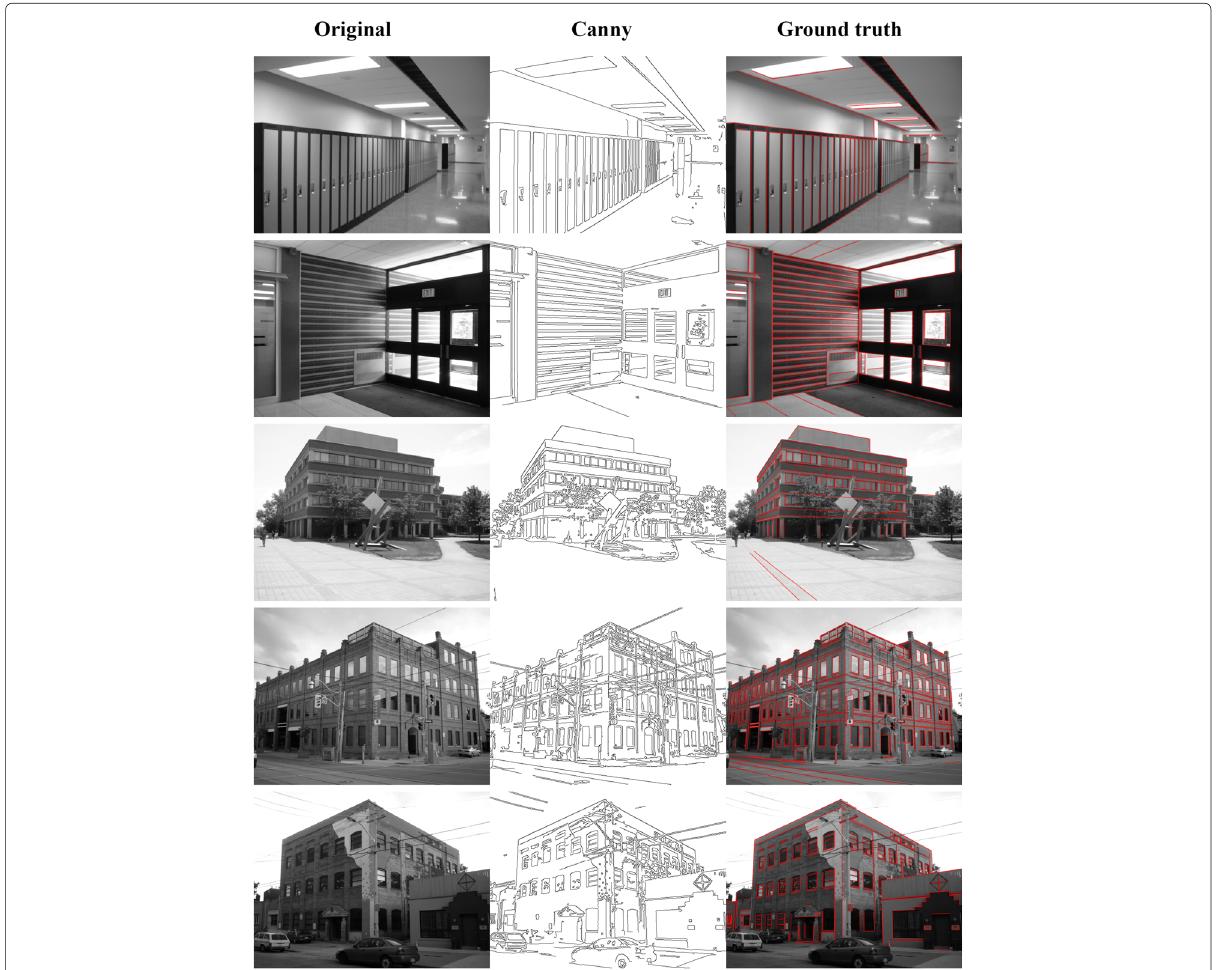
Fig. 11 First set of images used for the detection of endpoints, corners, and line